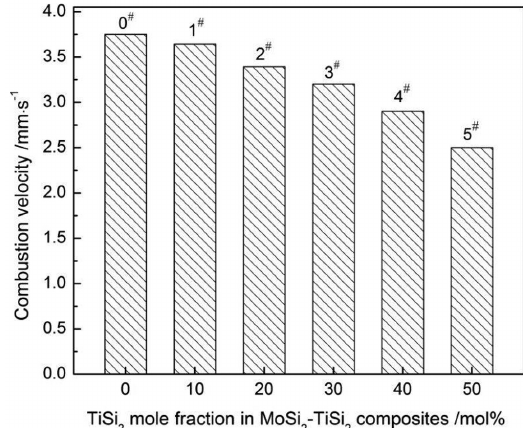
Figure 6. Variation of flame−front velocity of powder compacts with different starting nominal composition.